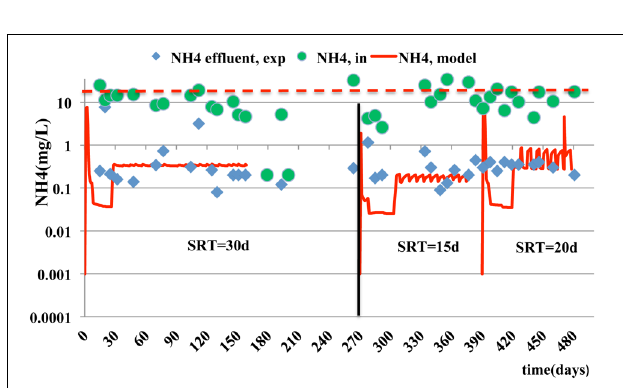
FIGURE 7 | Experimental measurements and model estimations for NH 4 effluent ( ___ ). NH 4 influent concentration is also shown (- - - -).